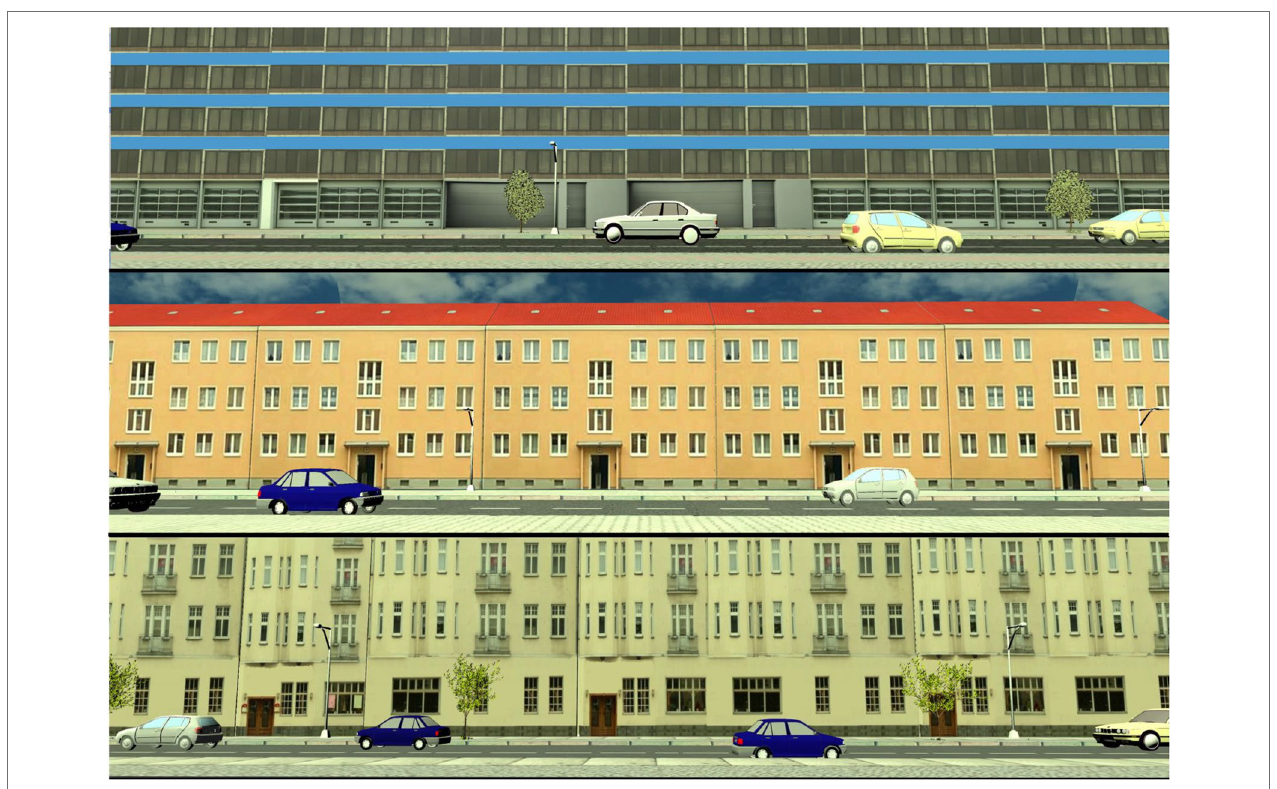
FIGURE 2 | The three different street scenarios of the go task, with cars crossing from both sides.